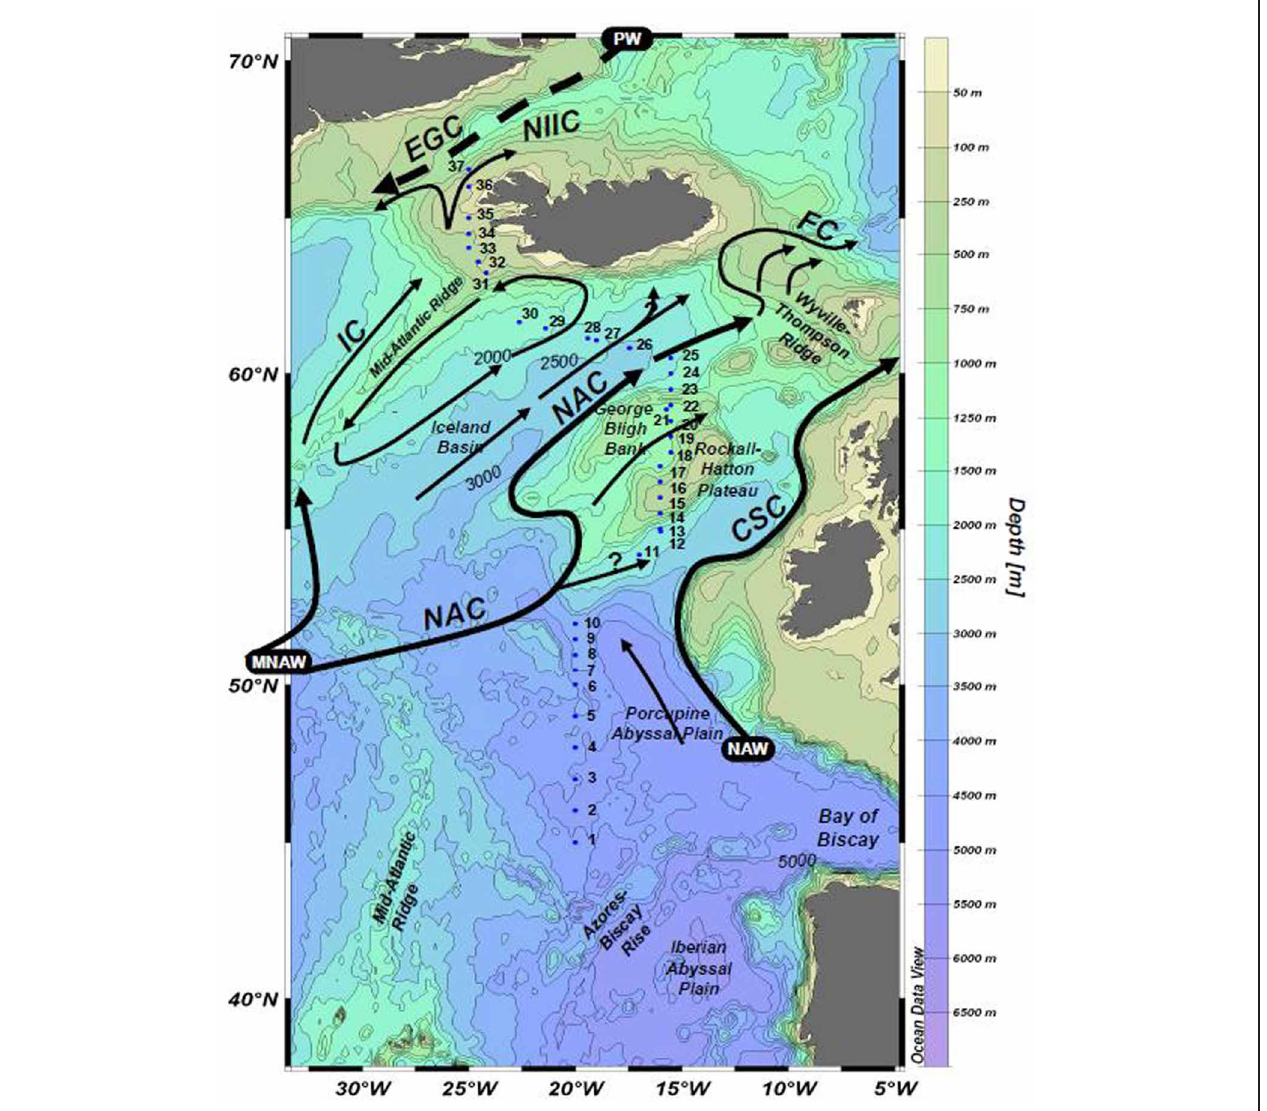
FIGURE 1 | Sampling locations along the NASB transect, shown with major surface currents. Surface sampling stations are numbered 1–37. Figure from LeBlanc et al.